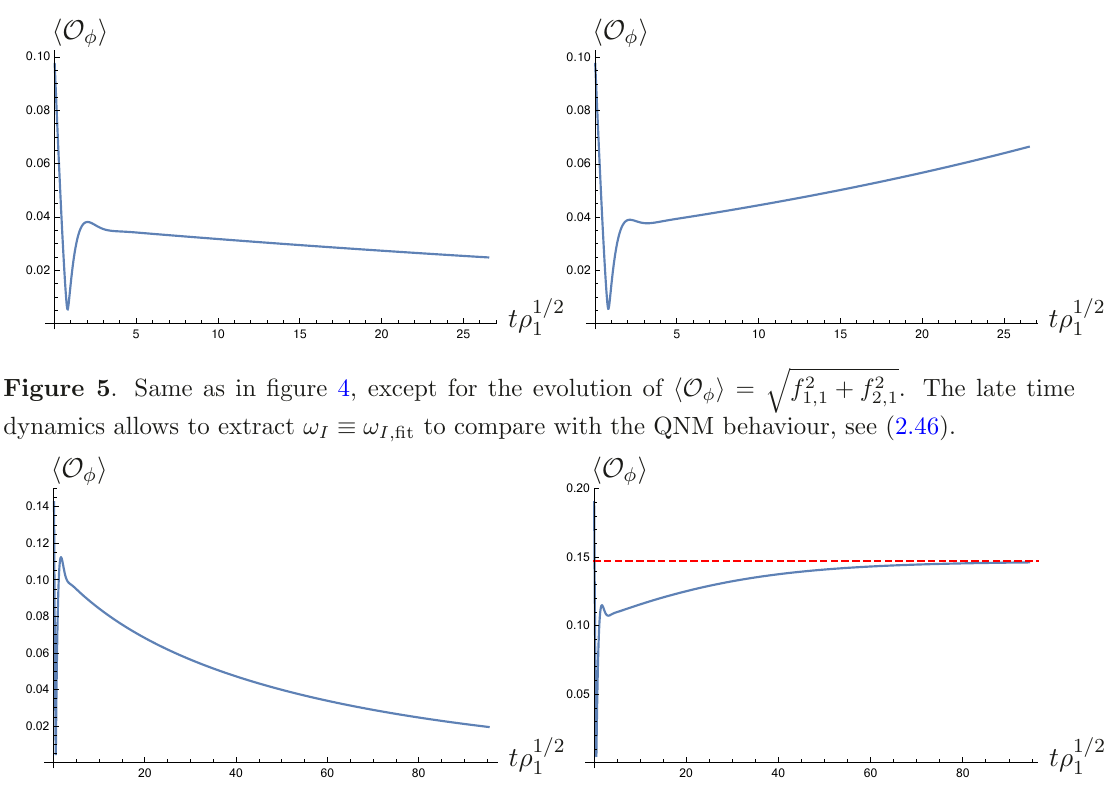
Figure 6 . Fully nonlinear evolution of DG-B model. Left panel corresponds to dynamics at energy density = 1 . 01538 crit (symmetric phase is stable); right panel describes spontaneous symmetry E E breaking at = 0 . 976328 crit . The red dashed line represents the energy density corresponding E E asymptotic (equilibrium) expectation value of the symmetry breaking operator microcanonical analysis of the model in section